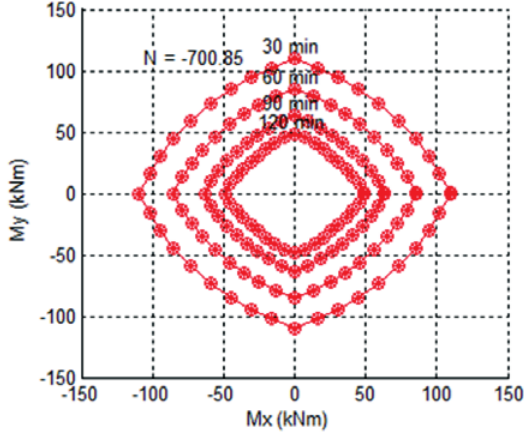
Figure 17c M - M curves of the cross-section with 8 ϕ 16 mm x y for N ⁄ = 0.20 Ncmax20 4 ϕ 16 mm (Figura 14.a) e 8 ϕ 16 mm (Figura 14.b) com discretiza -